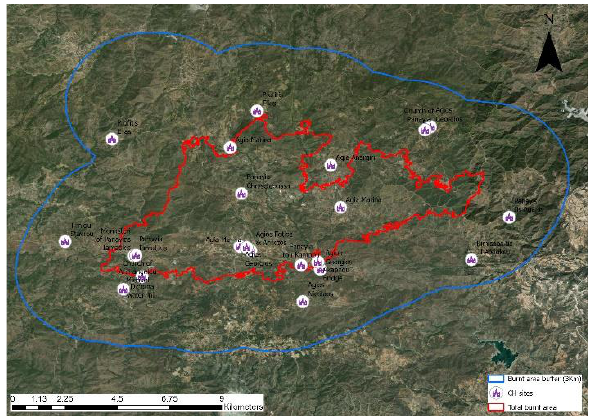
Figure 6 Map of the differenced Normalized Burn Ratio for the study area.